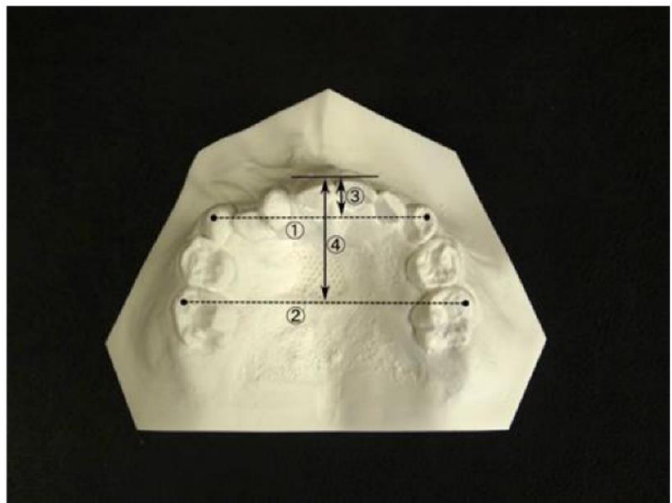
Figure 6. Measurement sites in the dentition model.